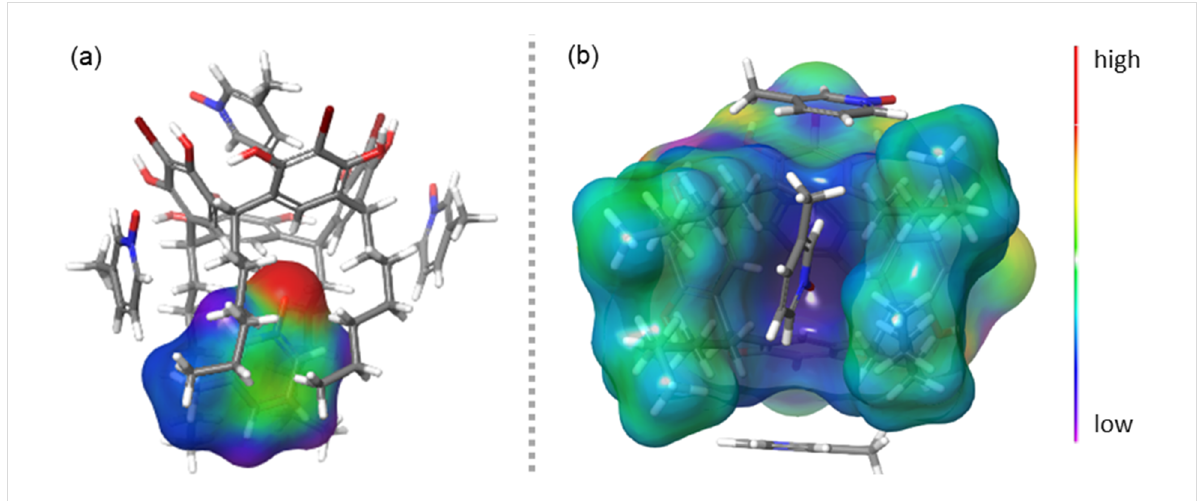
Figure 4: (a) The negative potential localised on the N -oxide oxygen in 3 @BrC6 and, (b) the positive charge distribution in lower-rim host cavity [+0.06 to − 0.06